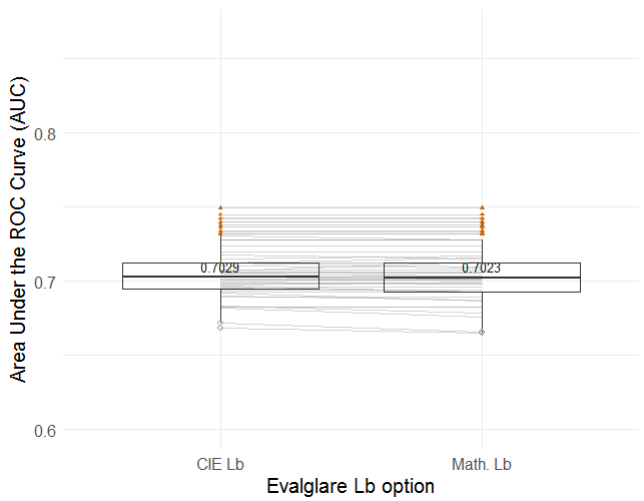
Figure 13. Boxplots of Spearman rho for the two background luminance definitions (laboratory study). Buildings 2018 , 8 , x FOR PEER REVIEW